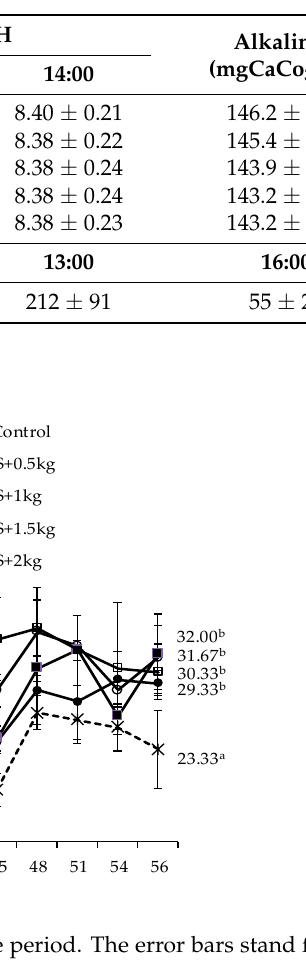
Table 2. Average temperature, DO, pH, and alkalinity in rearing tanks after 56 days of culture.